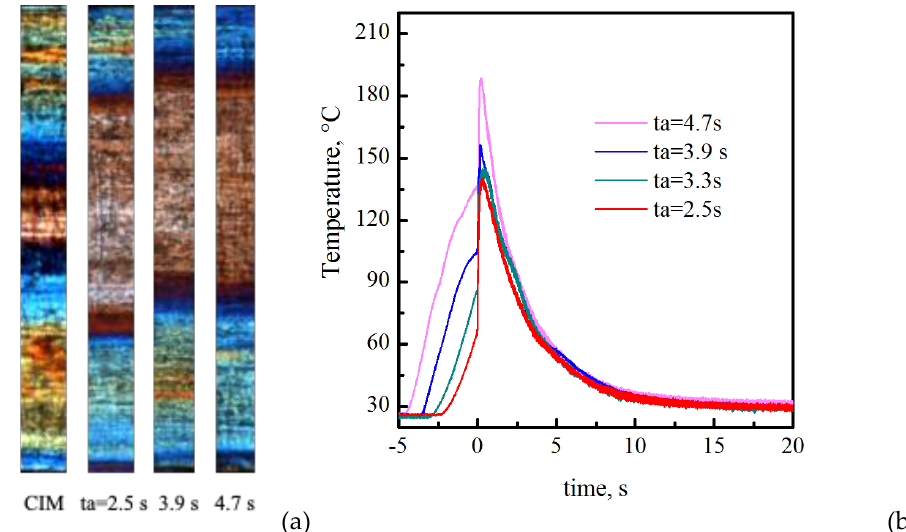
Figure 5. ( a ) Optical micrographs acquired at position P2 for four cases: conventional injection mold- ing condition (CIM), and three activation times: 2.5, 3.9, and 4.7 s, with a 68 W heating power. ( b ) Temperature evolutions recorded at position P2 for the same cases shown in Figure 5a.